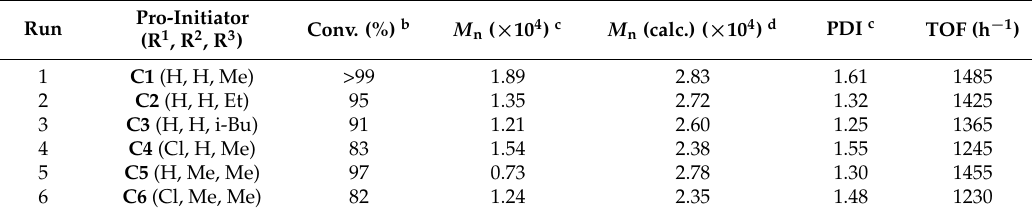
Table 5. The ROP of ε -CL promoted by C1 – C6 /BnOH a